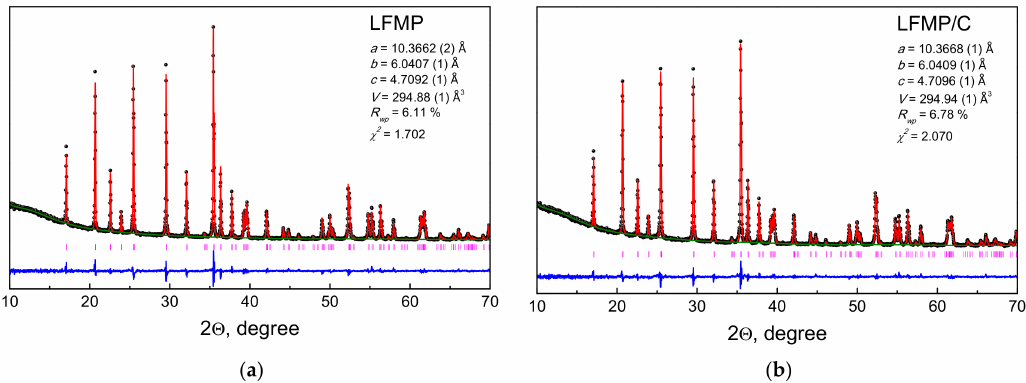
Figure 2. Rietveld refined X-ray powder di ff raction (XRD) patterns of carbon-free LiFe 0.5 Mn 0.5 PO 4 (LFMP) ( a ) and carbon-coated LiFe 0.5 Mn 0.5 PO 4 / C (LFMP / C) ( b